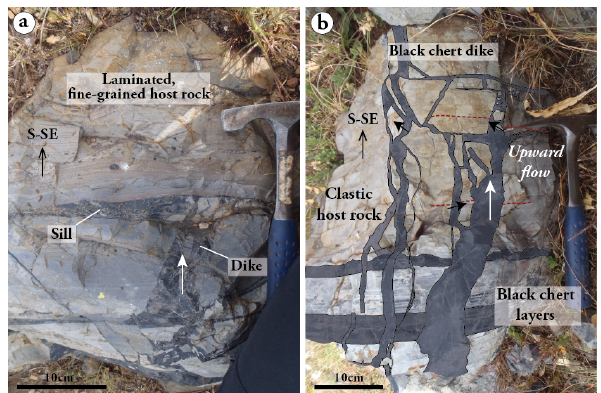
Figure 13. (a) Dike-and-sill structure: a central, vertical channel spreads out laterally along weak sedimentary plane to produce sills concordant with country rock bedding. The structure ends at the top by a final, <5cm thick sill. (b) Vertical dike narrowing in the younging direction. Black arrows indicate displacement ( ∼ 1cm) towards the top of the vein. Both photos are evidence for a migration of fluids from below (white